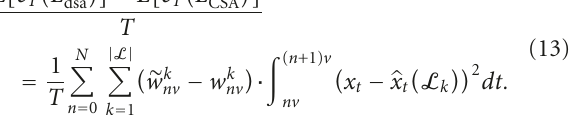
uses far less samples than uniform sampling for the same level of performance measured by MSE. We point